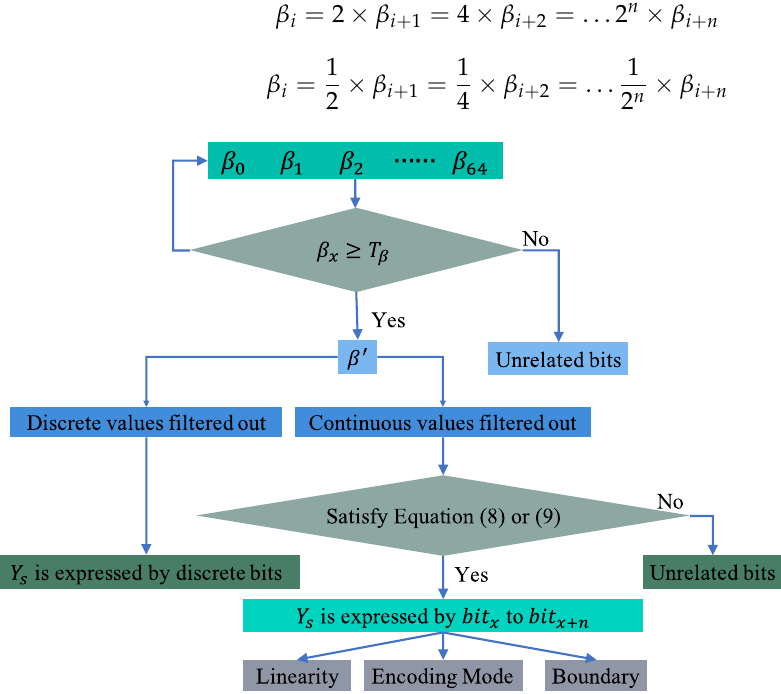
Figure 8. Diagram of bit-level reverse.